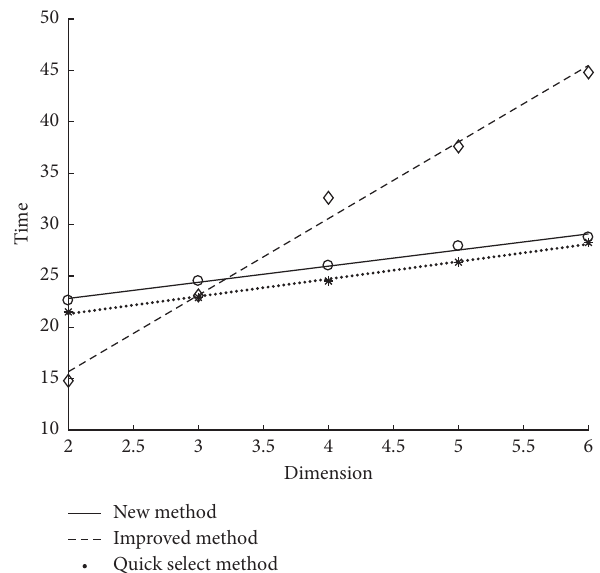
Figure 5: Construction time (seconds) for 2 24 randomly generated real elements in different